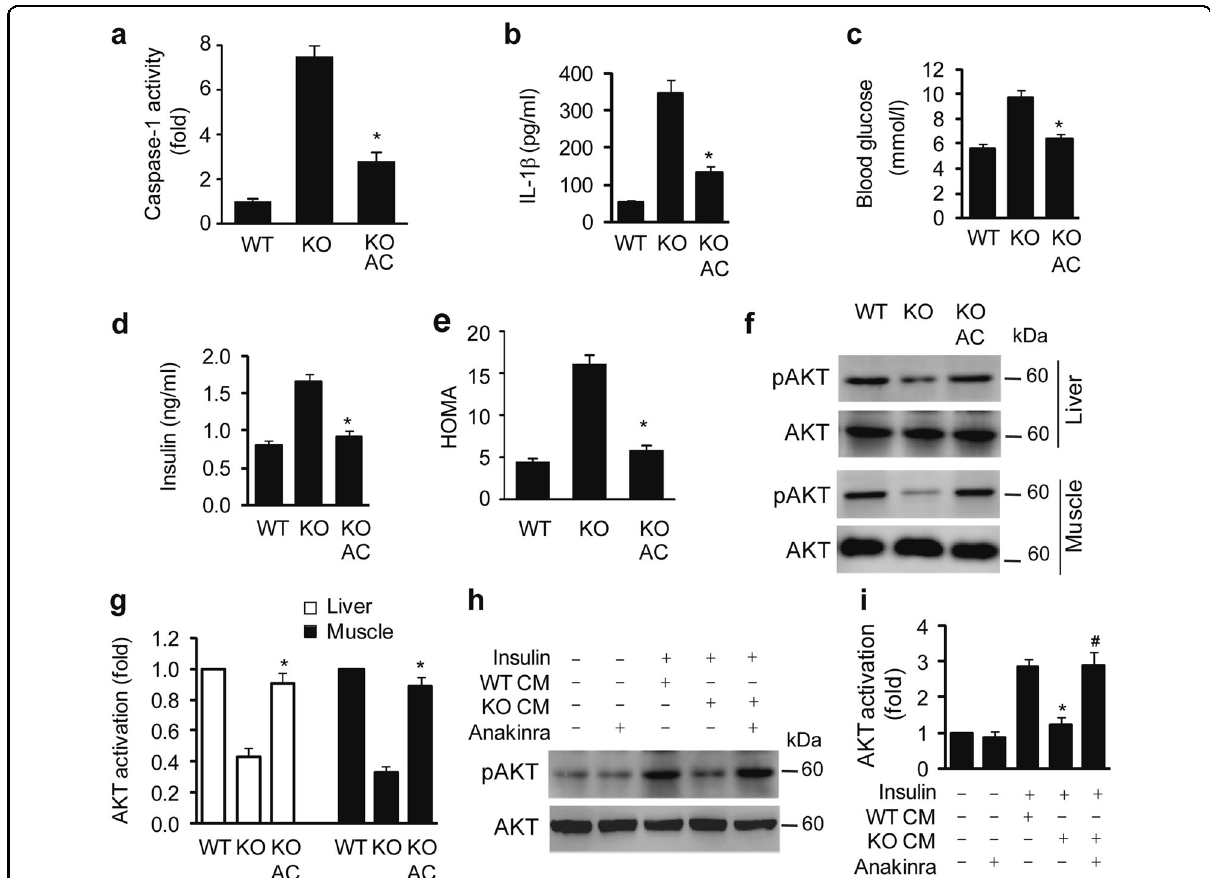
Fig. 5 Pharmacological inhibition of the NLRP3 in fl ammasome prevents insulin resistance in Kir6.1 KO mice. a – e The caspase-1 inhibitor AC- YVAD-CMK (AC) inhibited caspase-1 activity ( a ), serum IL-1 β ( b ), basal blood glucose ( c ), fasting serum insulin ( d ), and HOMA ( e ) in Kir6.1 KO mice; n = 6. f AC-YVAD-CMK enhanced AKT activation in the liver and muscle of Kir6.1 mice. g Quanti fi cation of data shown in ( f ); n = 4. Kir6.1 KO mice were intraperitoneally injected with AC-YVAD-CMK at a concentration of 40 mg/kg body weight for 7 days. The data are presented as the mean ± SEM. * p < 0.05 vs KO. h Representative immunoblots showing the effect of anakinra on insulin-mediated AKT activation. Primary hepatocytes were pretreated with conditioned medium (CM) generated from WT and Kir6.1 KO macrophages for 24 h in the absence or presence of anakinra and then stimulated with insulin (200nM) for 10 min. i Quanti fi cation of shown in ( h ). The data shown are the mean ± SEM from four independent experiments. * p < 0.05 vs. cells treated with WT CM; # p < 0.05 vs. cells treated with KO